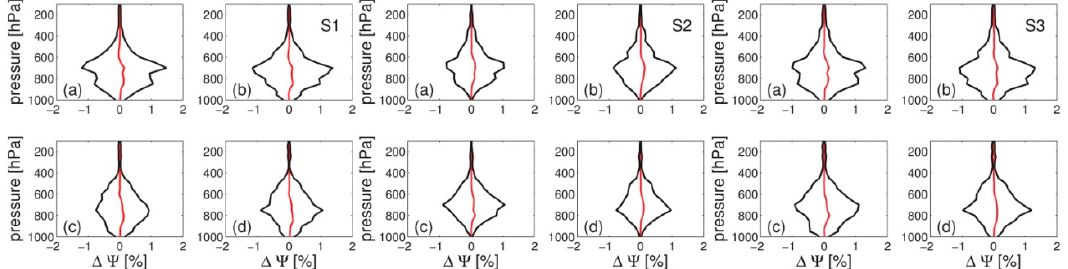
Figure 6. Same as Figure 3 but data from the station network are assimilated.